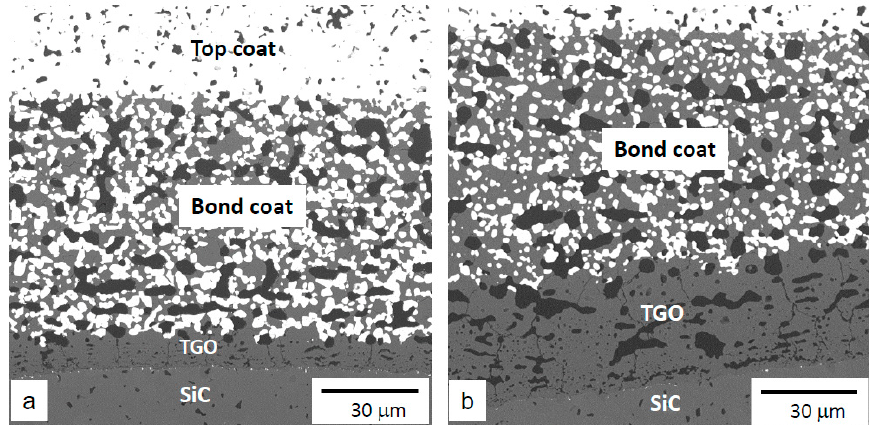
Figure 6. Cross-sections of coated sintered SiC after cyclic oxidation at 1427 °C in 90 vol.% H 2 O + 10 vol.% O 2 : ( a ) 100 h; ( b ) 500 h.